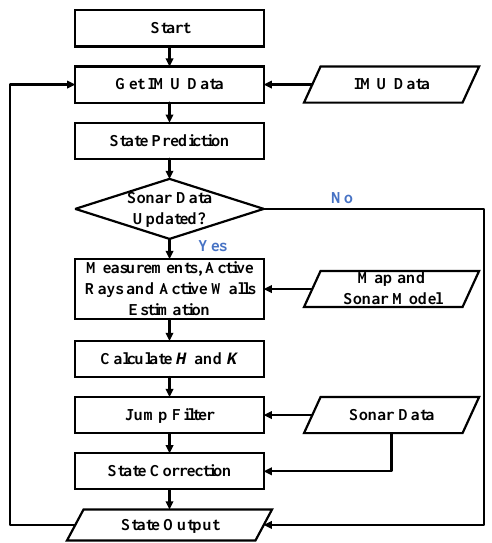
Figure 10. The extended Kalman filter (EKF) flowchart.